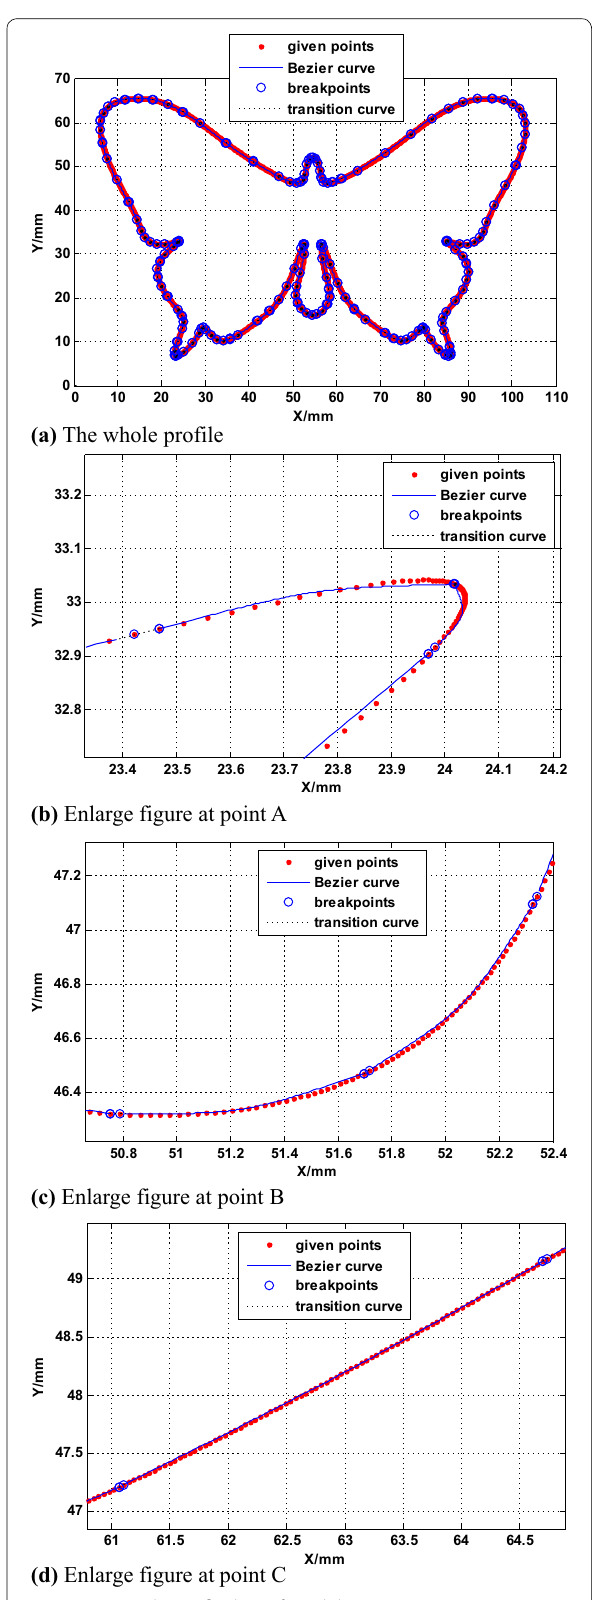
Figure 7 A 2-D butterfly shape for